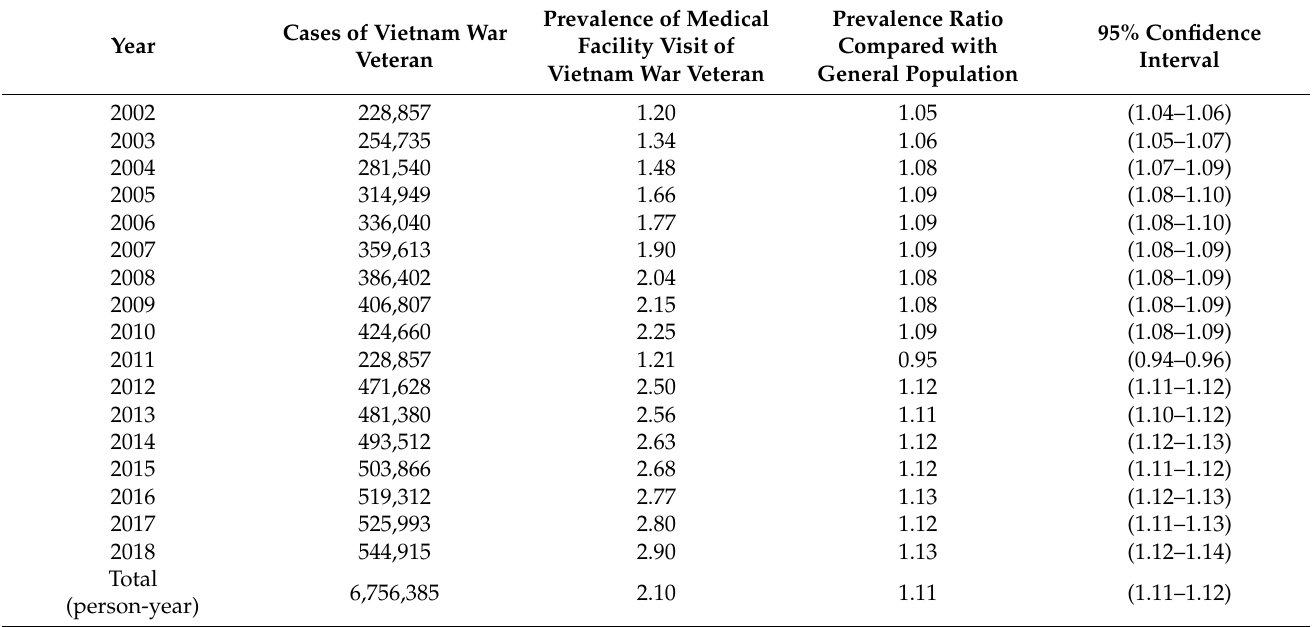
Table 5. Distribution of medical facility visit history by year of the Vietnam War veteran and second- generation cohort during follow-up